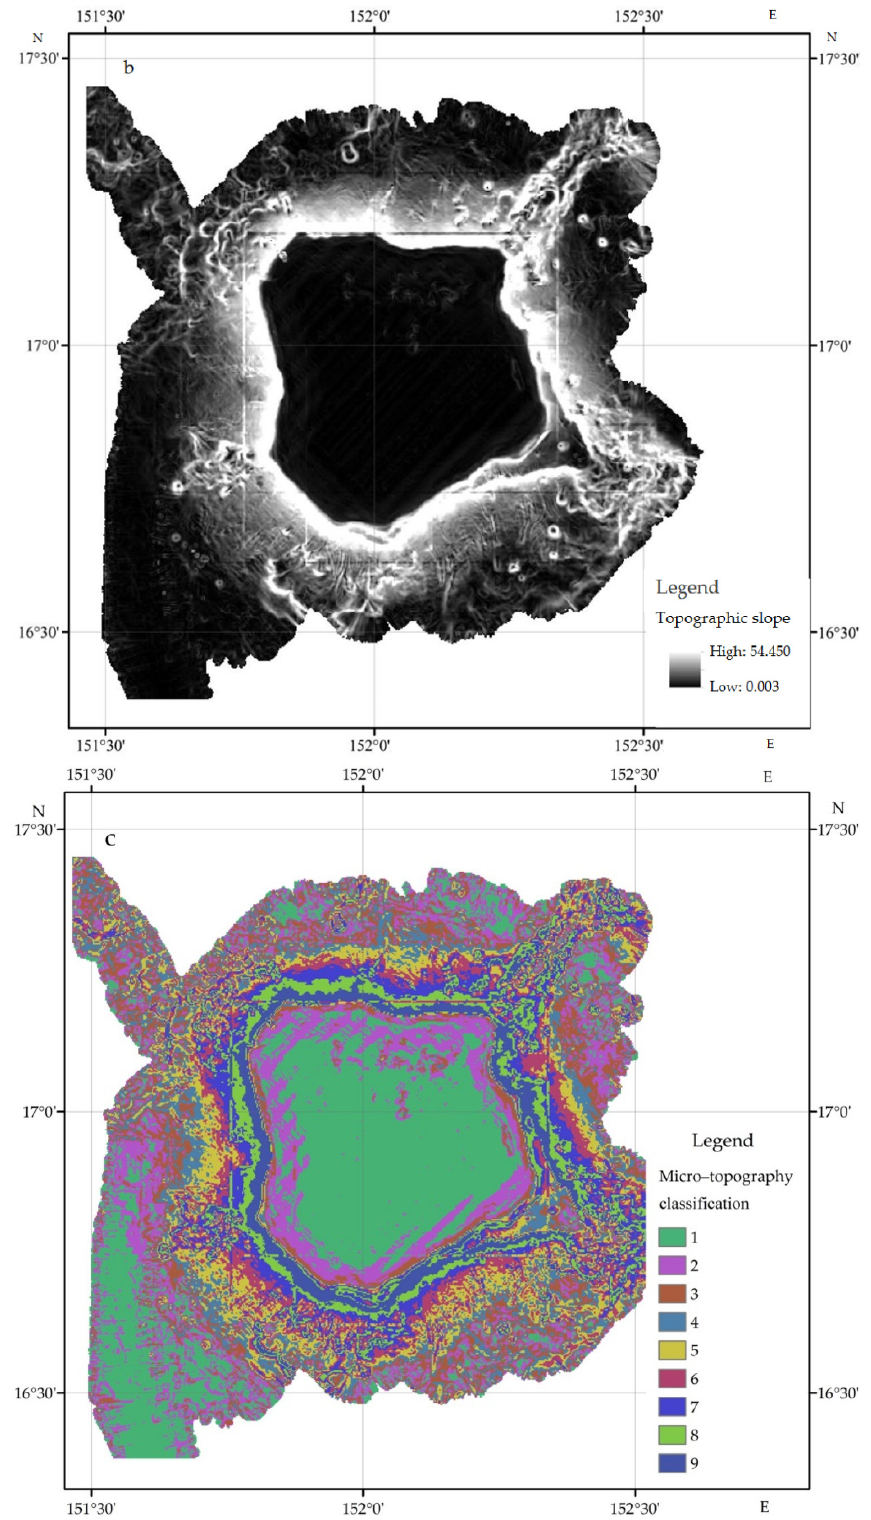
Figure 2. Topography of Il’ichev seamount: ( a ) unsupervised classification of seamount topography; ( b ) topography slope analysis; ( c ) micro-topography classification.